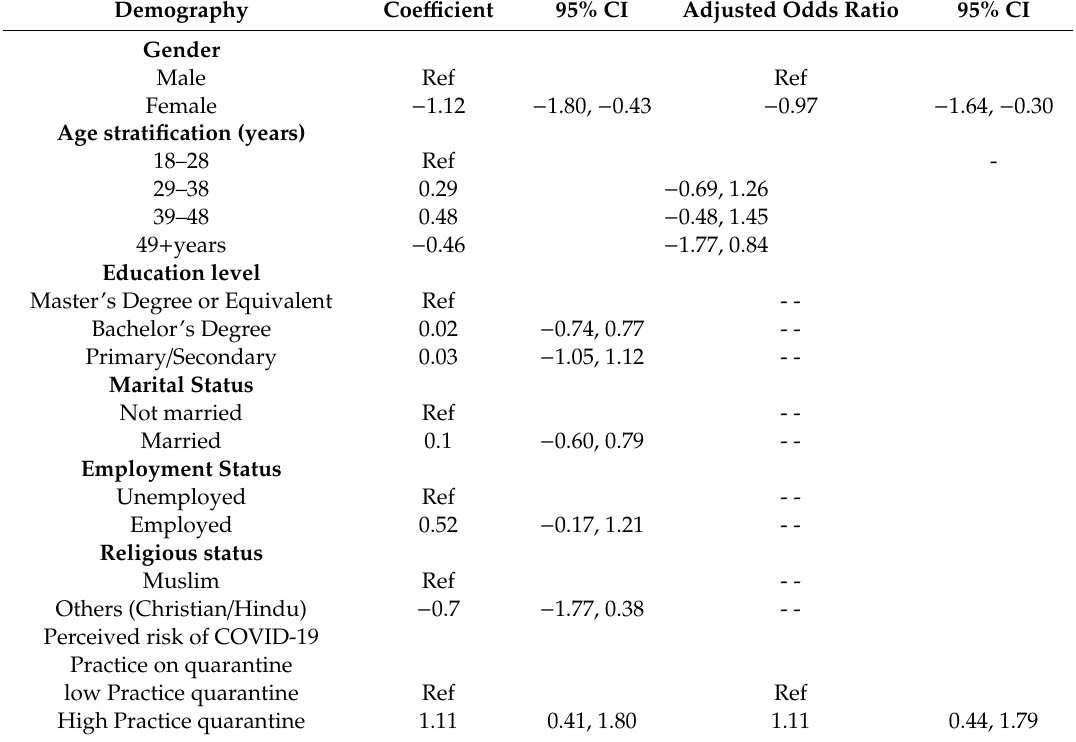
Table A1. Coe ffi cients for factors associated with the perceived risk of COVID-19 among the respondents in Bangladesh during the early lockdown period. Confidence intervals CI including zero are not significant